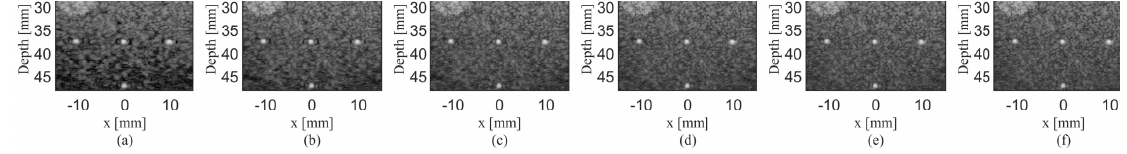
Figure 19. Experimental images with point targets formed by SLSC+NSVD with β from 1 ( a ) to 6 ( f ).